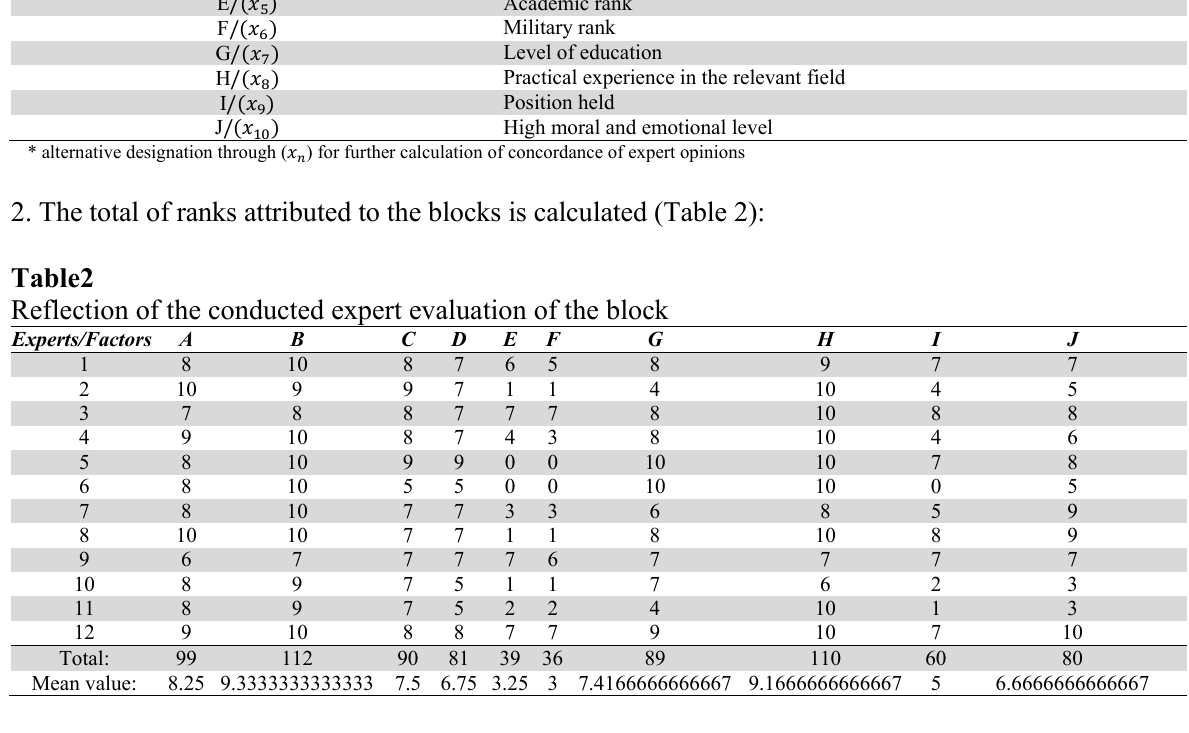
Assigning symbols to the questionnaire blocks for further calculations Designation of the block Name of the block A /( (cid:1876) (cid:2869) (cid:4667) * General skills and abilities B/ (cid:4666)(cid:1876) (cid:2870) (cid:4667) Ability to think C /(cid:4666)(cid:1876) (cid:2871) (cid:4667) Ability to adapt Ability to cooperate